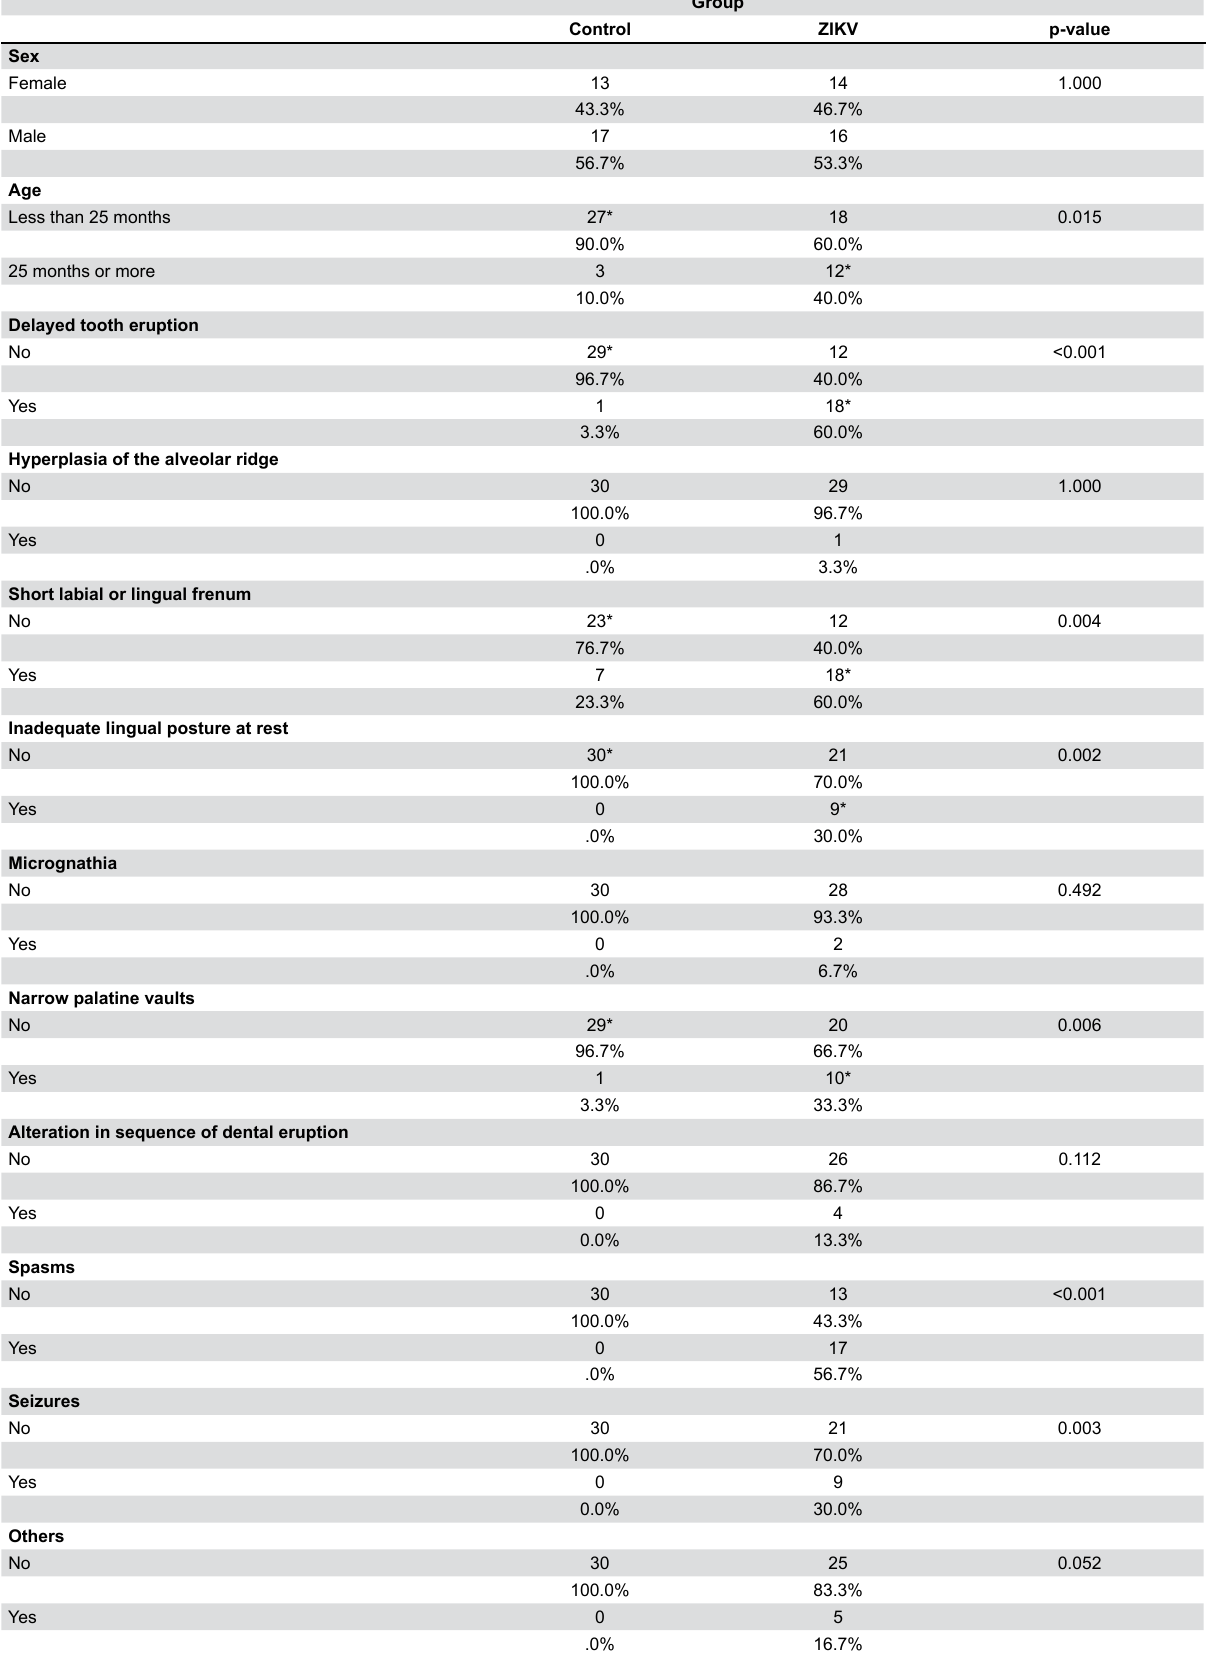
Clinical and x-ray oral evaluation in patients with congenital Zika Table 3- Case-control evaluation of clinical characteristics and delays in ZIKV children